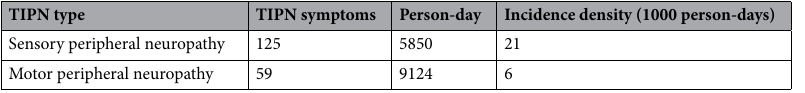
Table 2. Taxane-induced peripheral neuropathy (TIPN) incidence density (1000 person-day), (total n = 141). TIPN taxane-induced peripheral